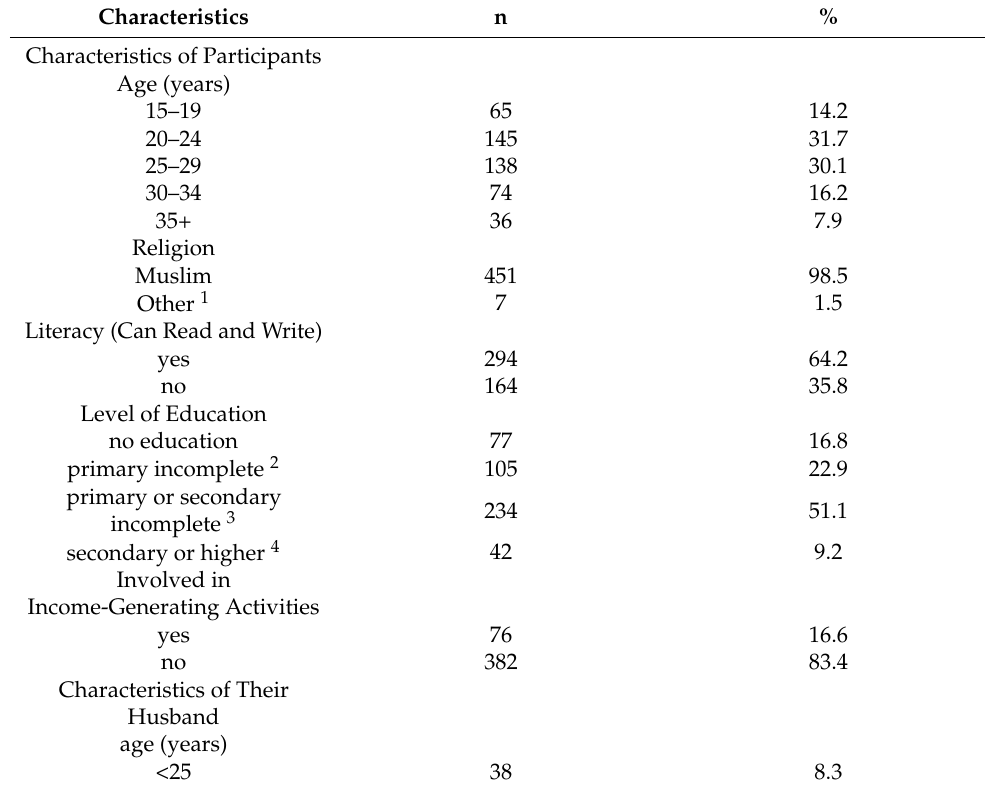
Table 1. Background characteristics of the respondents (N = 458). Characteristics n